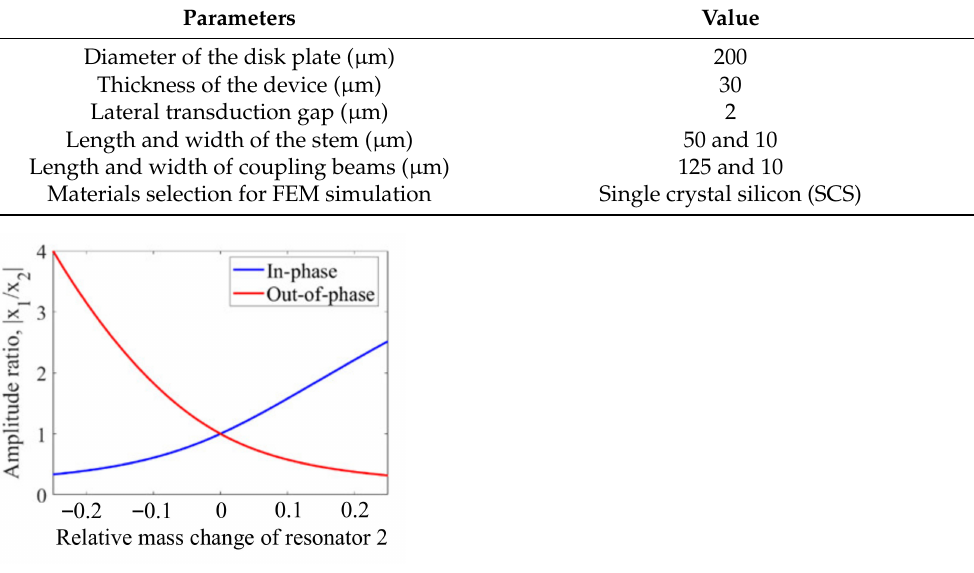
Figure 13. Relationship between the amplitude ratio change and the relative mass change on res- onator